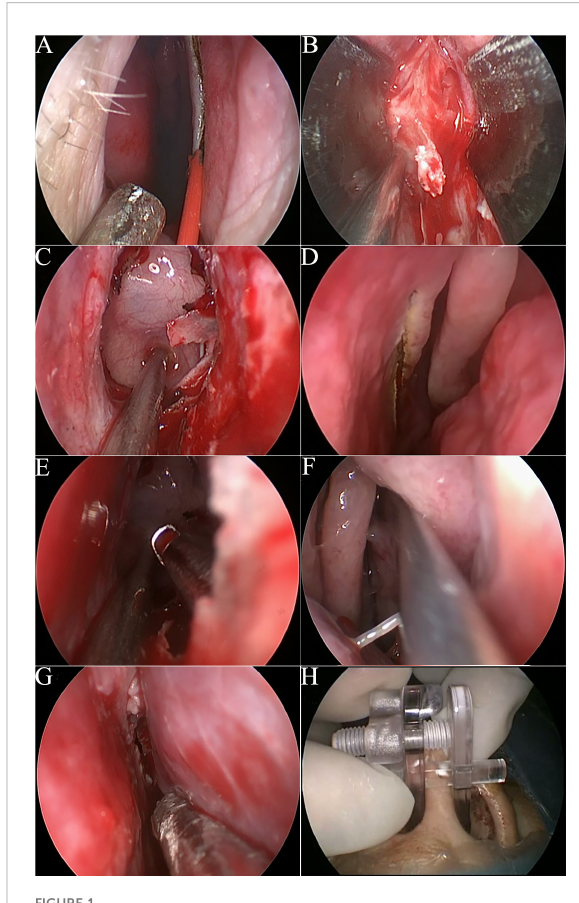
FIGURE 1 Intraoperative images of surgical procedures. (A) The incision of the right nasal cavity. (B) The nasal speculum was inserted into the level of sphenoidal rostrum. (C) The shaped transseptal corridor. (D) The incision of the left nasal cavity. (E) 2-surgeon/4 or 3-hands manipulation from bilateral incisions. (F-H) . The right and left nasoseptal mucosal fl aps were replaced and fi xed by a nasal septal